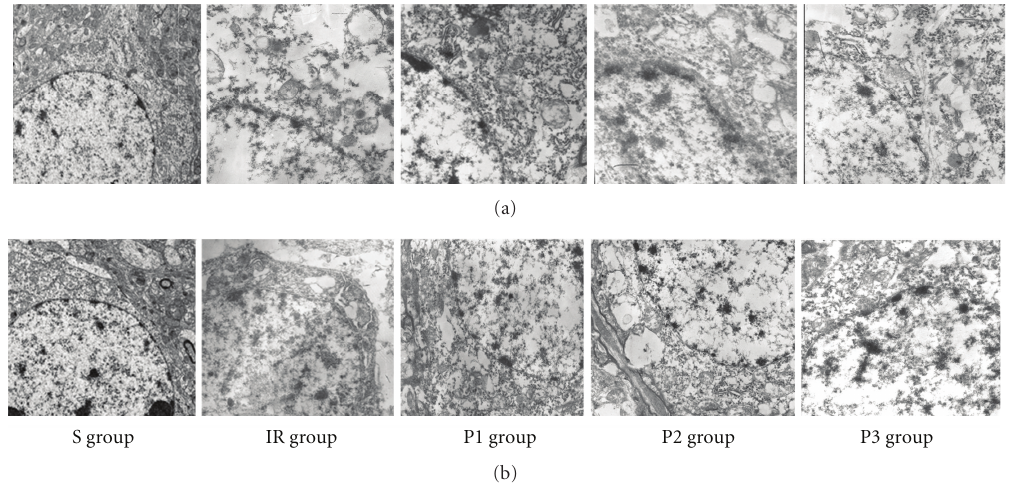
Figure 5: (a) Hippocampus ultrastructural histopathologic changes in five groups at 24 h ( × 5000). (b) Hippocampus ultrastructural histopathologic changes in five groups at 72 h ( ×